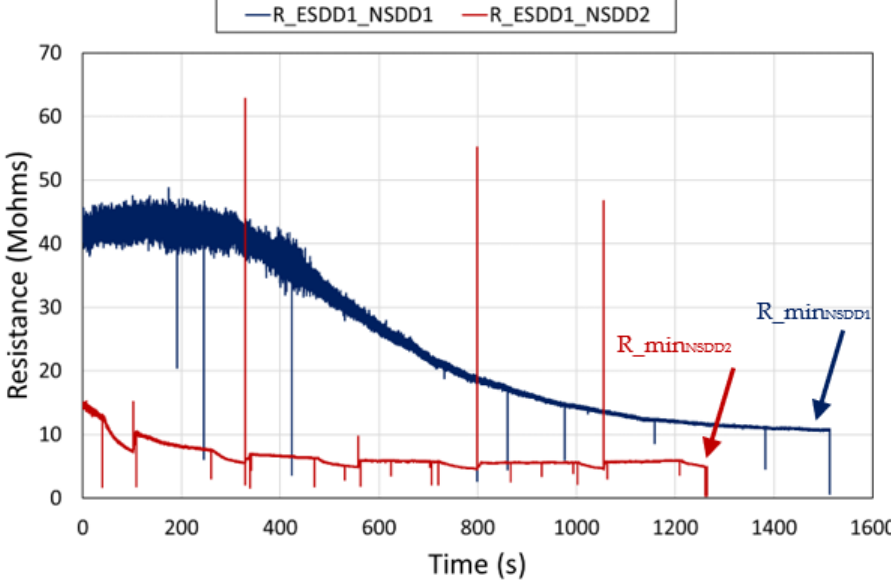
Figure 10. Leakage resistance during the low-voltage (840 V) test with ESDD 1 .